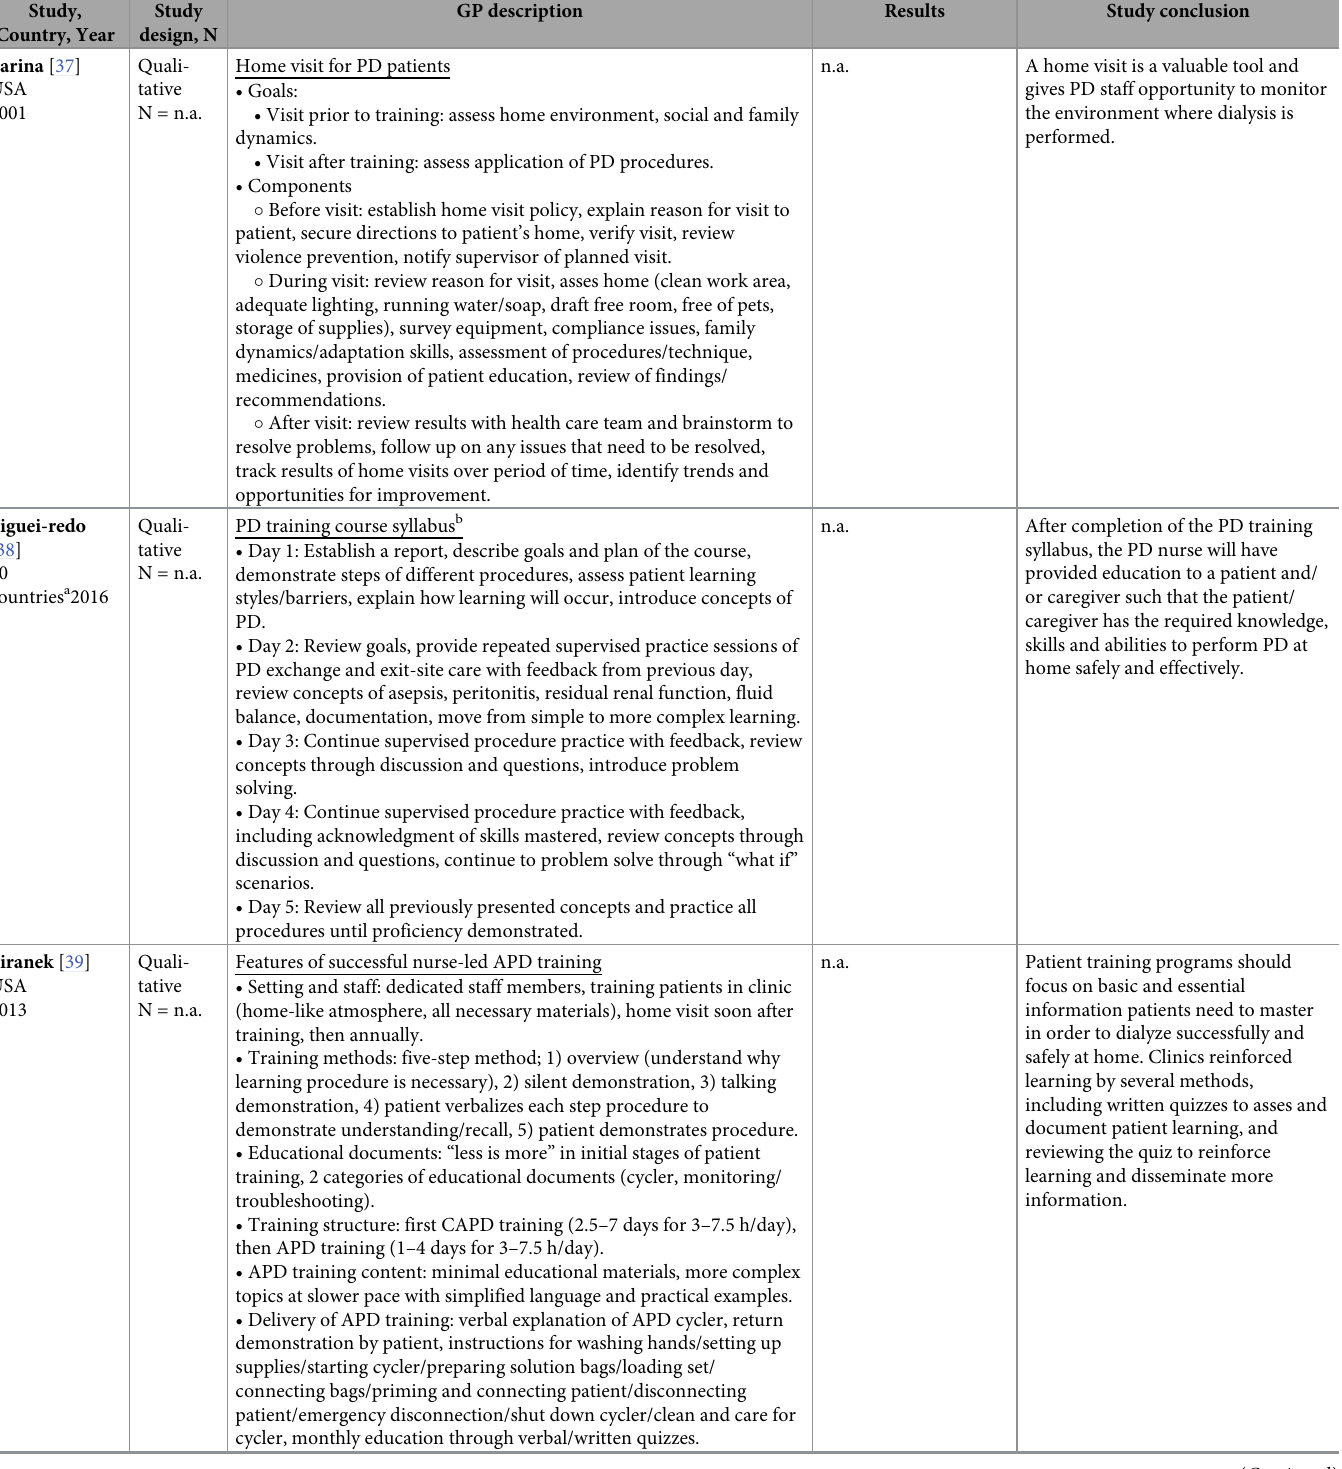
Table 2. Characteristics of studies on dialysis education. Study, Country,